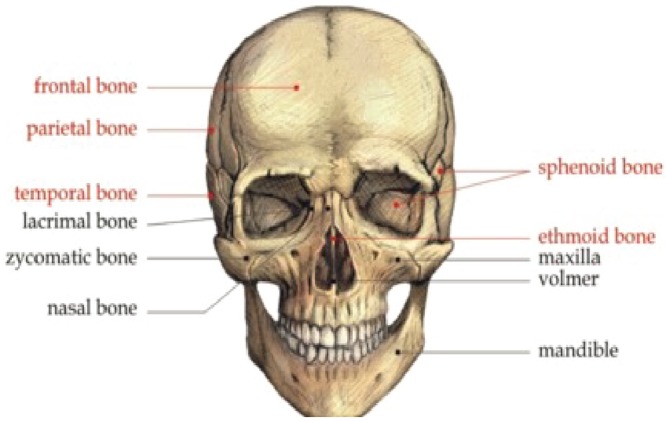
Craniofacial bones.